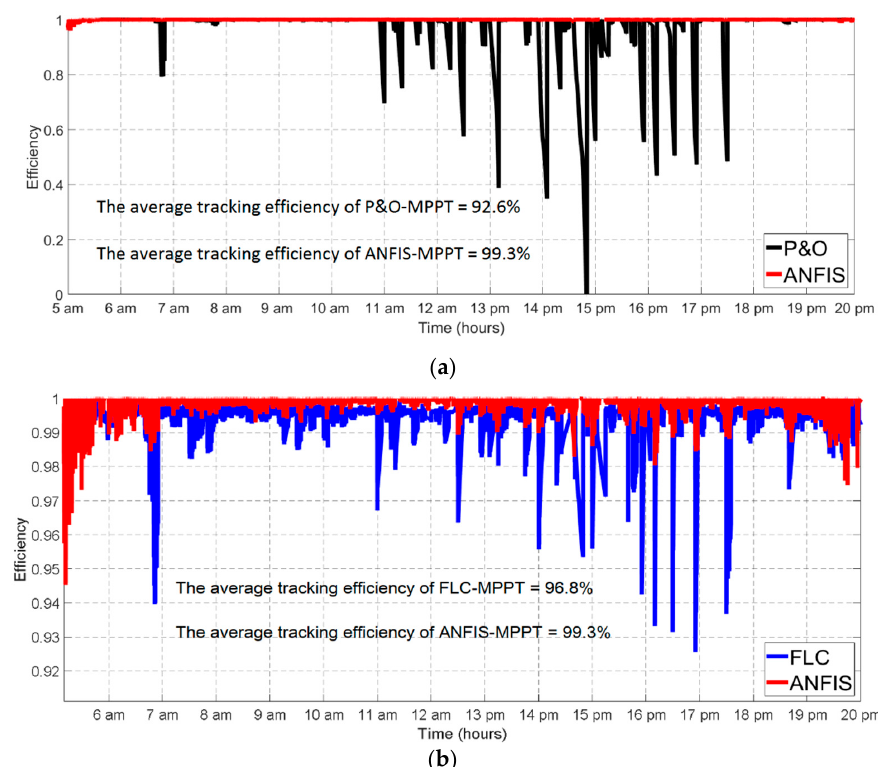
Figure 13. ( a ) Tracking power for P&O versus the ANFIS method and ( b ) tracking power for the FLC versus the ANFIS technique.